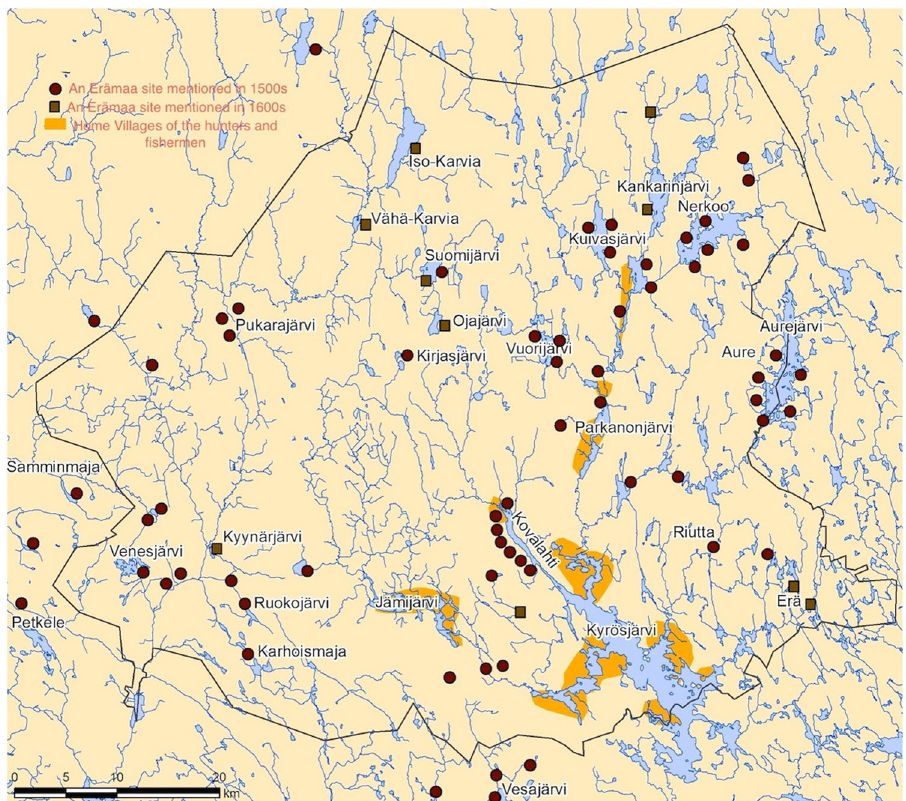
Fig. 2 A map detailing examples of erämaa sites from the lake Kuivasjärvi area from 1500s and 1600s in Western Finland. Map: Snowchange, 2022. Used with